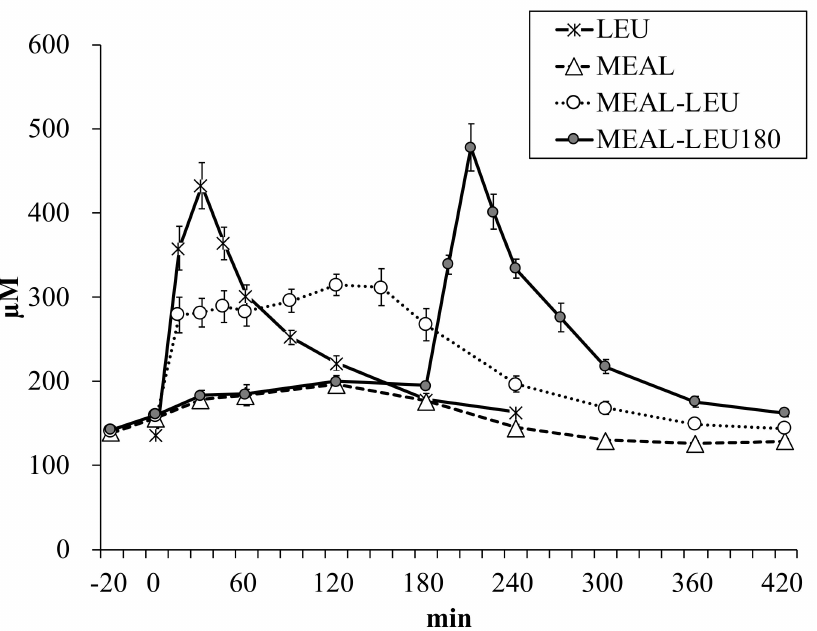
Figure 6. Mean ± SE ( n = 10) plasma leucine concentration changes over time. LEU, intake of leucine only; MEAL, intake of mixed meal only; MEAL-LEU, intake of mixed meal with leucine intake immediately afterwards; MEAL-LEU180, intake of test mixed meal followed by leucine intake after 180 min. 3.5. Area under the Curve with Respect to Increase (AUCi) for Plasma Essential Amino Acids and Leucine